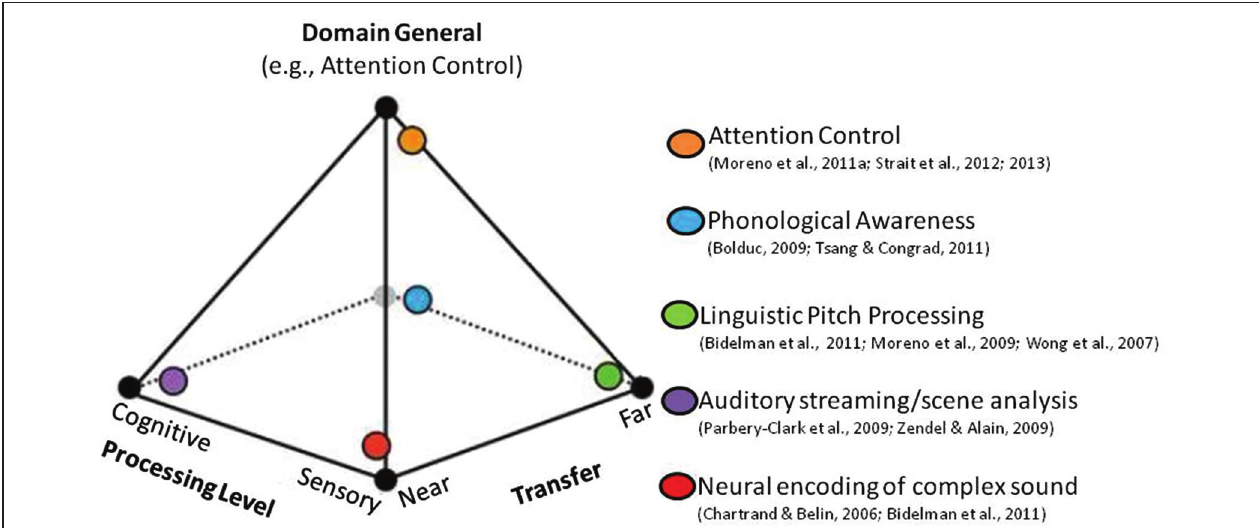
of transfer and cognitive benefits observed across many studies that have examined music-related plasticity (denoted by the colored orbs). The specific amount of benefit and the extent of transfer from music to language (represented by the location within the pyramid model) might be mediated by the extent to which cognitive skills (e.g., attention/inhibition control) are tuned by music training